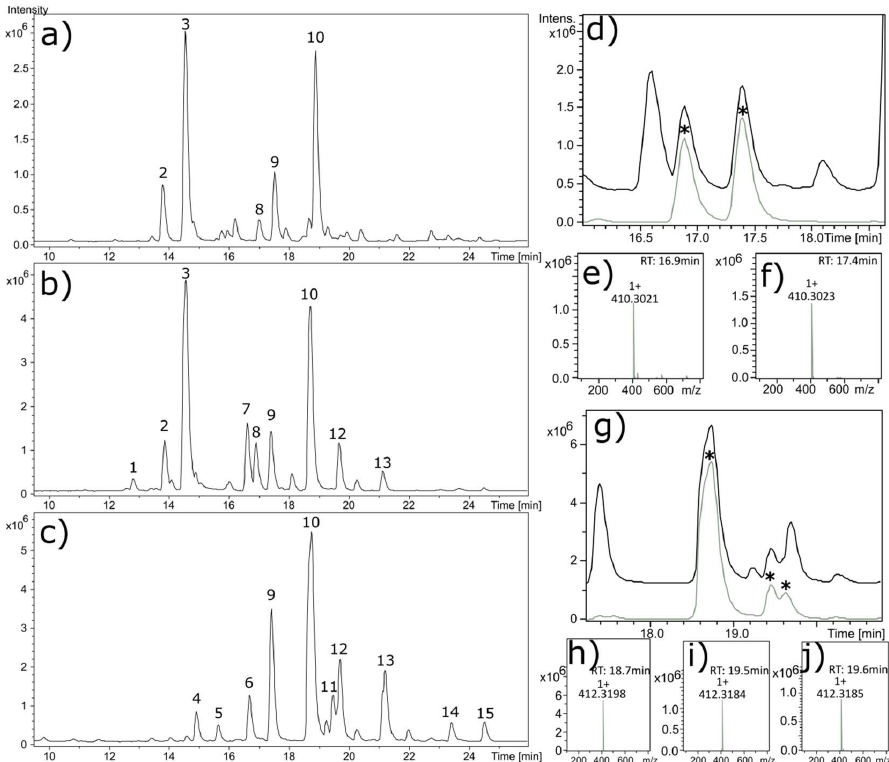
Figure 1. Alkaloid chromatograms for biomass extracts from the ( a ) leaf, ( b ) stem, and ( c ) root/rhizome of V. californicum . Common and unique alkaloids identified by MS are observed in each extract. Labelled peaks correspond to the data summarized in Supplemental Table 1. Additional observed peaks that are not labelled did not have molecular formulas consistent with jervine-type alkaloids. Extracted ion chromatograms (EIC) are shown in ( d ) and ( g ) demonstrating the presence of veratramine and cyclopamine isomers in stem and root/rhizome extracts, respectively. The total ion chromatogram is shown in ( d ) for the stem extract (black) and EIC (grey) generated using the m / z window 410.3023 ± 0.01. The mass spectra for the peaks indicated by * in ( d ) are shown in ( e ) and ( f ). The total ion chromatogram is shown in ( g ) for the root extract (black) and the EIC (grey) generated m / z window 412.3186 ± 0.02. The mass spectra for the peaks indicated by * in ( g ) are shown in ( h – j ). Table 1. Summary of the data corresponding to peaks identified in Figure 1a–c. N/A is used to designate alkaloids with identity not available; N/A 1 may be etioline or another isomer of isorubijervine; N/A 2 may be an isomer of veratramine, and N/A 3 may be an isomer of cyclopamine. Peak Retention Time (min) m / z Molecular Formula